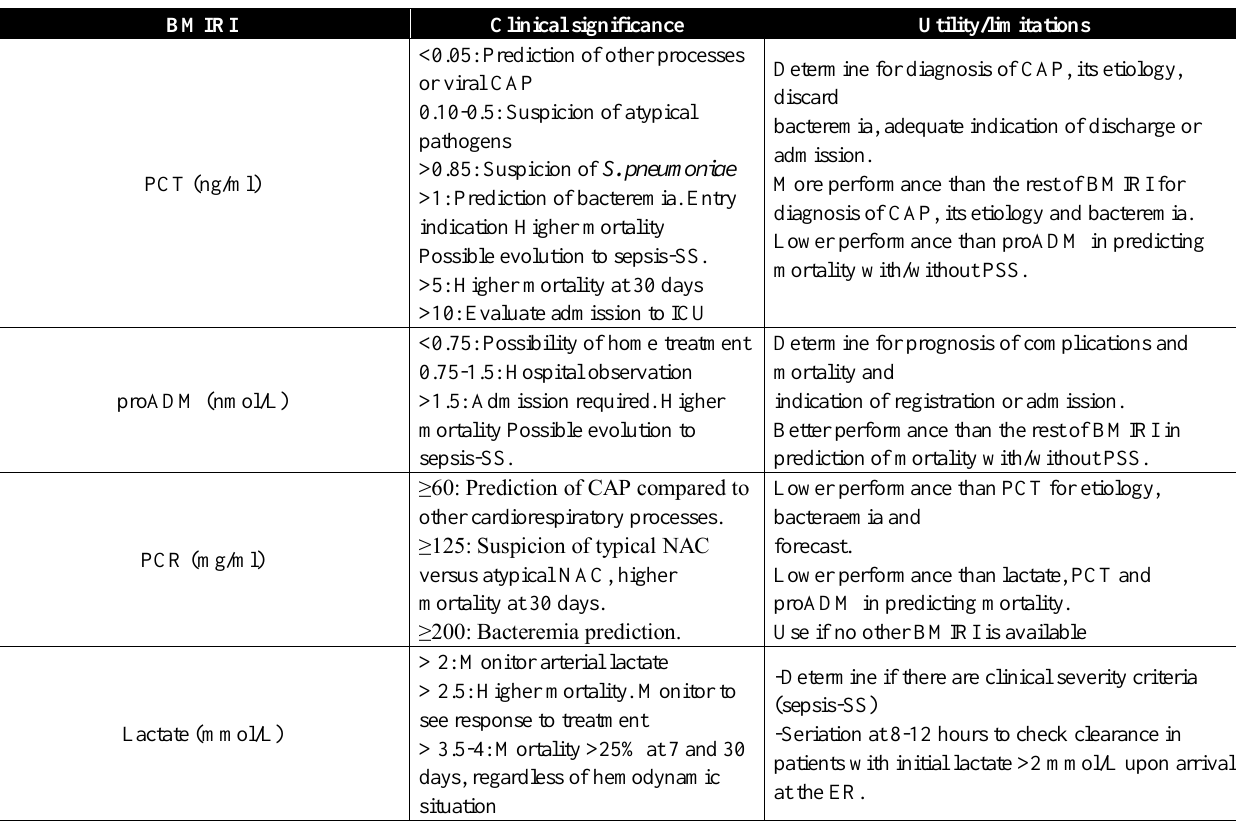
Table 6: Recommendations on the use of biomarkers in patients affected of CAP in ER. BMIRI: Biomarker of inflammatory response and infection; CAP: Community acquired pneumonia; ER: Emergency Room; PCT: Procalcitonin; PCR: C-reactive protein; proADM: proadrenomedulin; PSS: Prognostic severity scales; SS: septic